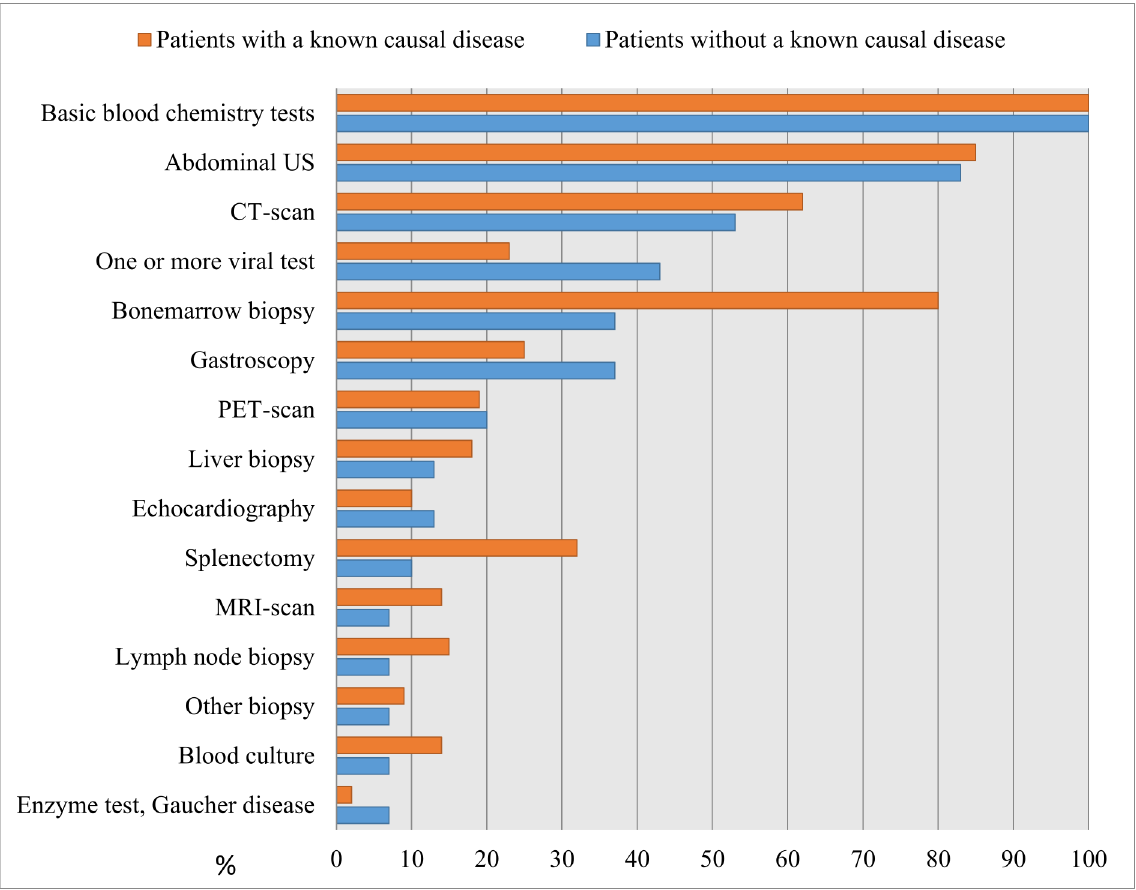
Fig 2. Diagnostic work-up. The percentages of patients that underwent different diagnosticproceduresduringthe investigation.